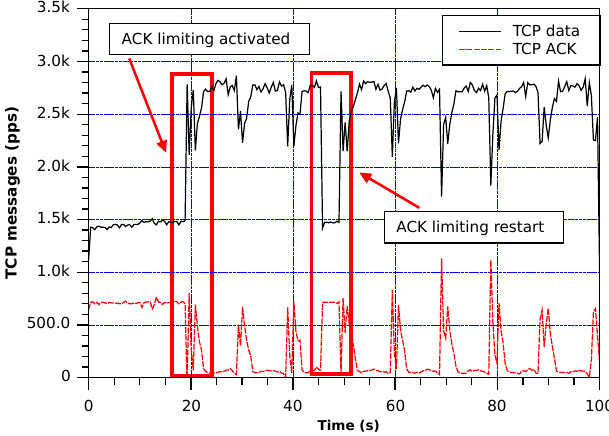
Figure 6. TCP data and acknowledgment packet rate on router with ACK rate